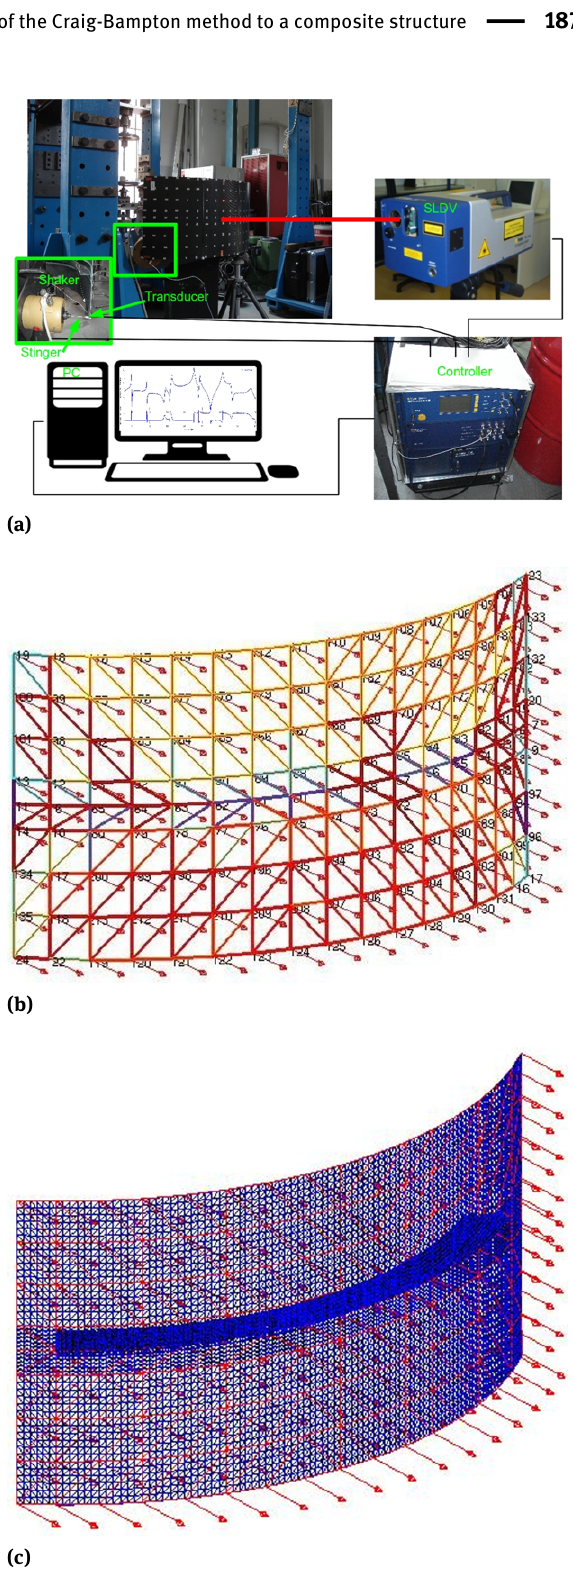
Figure 1: Experiment: a) Experimental set-up; b) 153 Y-direction sensors; c) 153 sensors in the FEM model